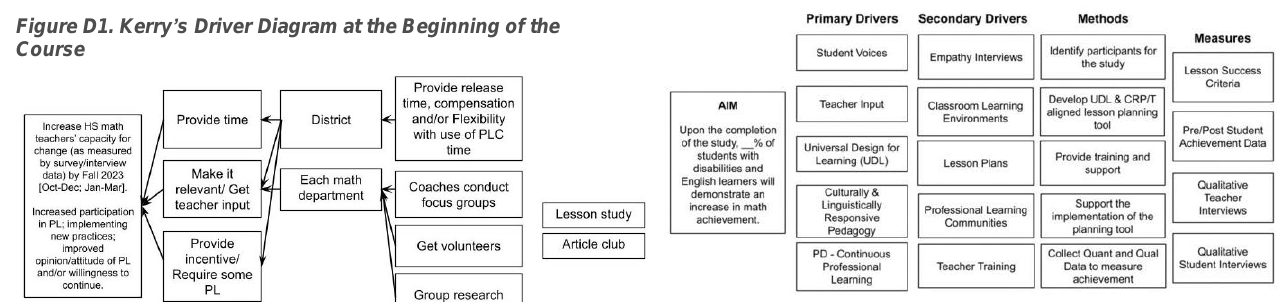
Figure D5. Nicole’s End-of-course Driver